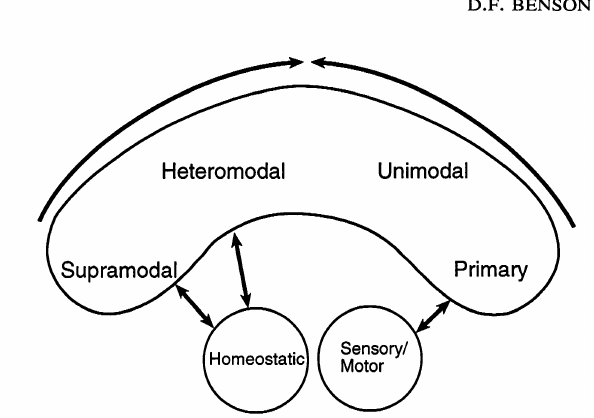
FIG. 4. Graphic illustration demonstrating bimodal subcortical cortical connections and general directions of sensory-motor and homeostatic influence in the